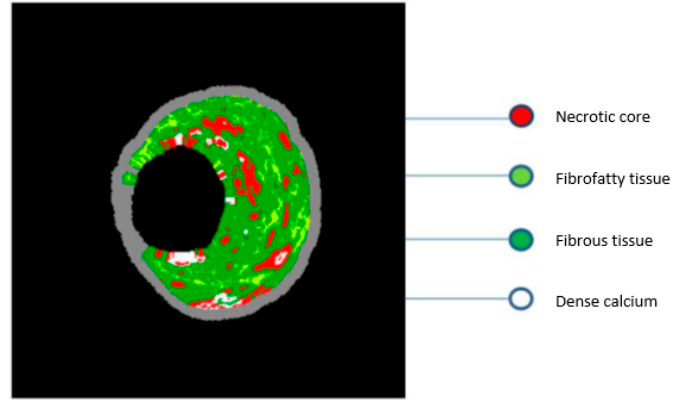
Figure 2. Intravascular ultrasound images analyzed by virtual histology algorithms (VH–IVUS). The components of the atherosclerotic plaque are fibrous connective tissue (dark green), fibro-fatty tissue (light green), necrotic core (red) and dense calcium (white).